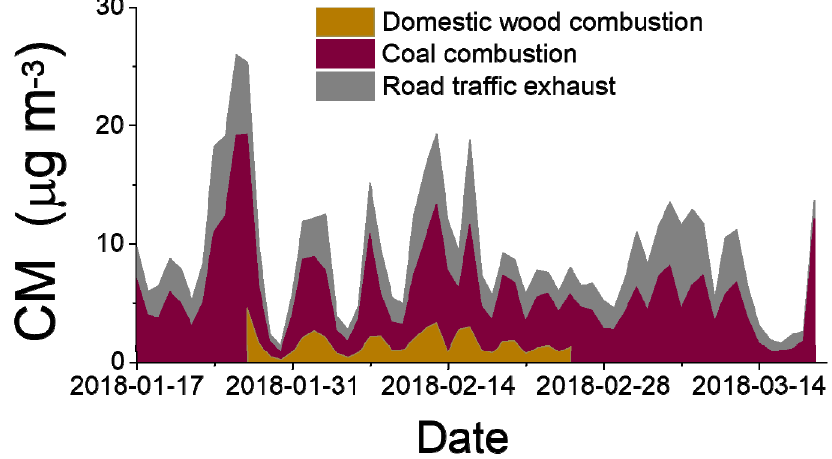
Figure 3. Estimated contribution from domestic wood and coal combustion and road traffic exhaust to CM concentrations in Diabła G ó ra during the measurement period. The hour resolved source apportionment as obtained from the aethalometer method has been averaged to 24 h in this graph to be able to compare with 24 h values for the wood combustion contribution. During those days when levoglucosan data were missing, the contribution in brown represented the combined wood and coal combustion contribution.